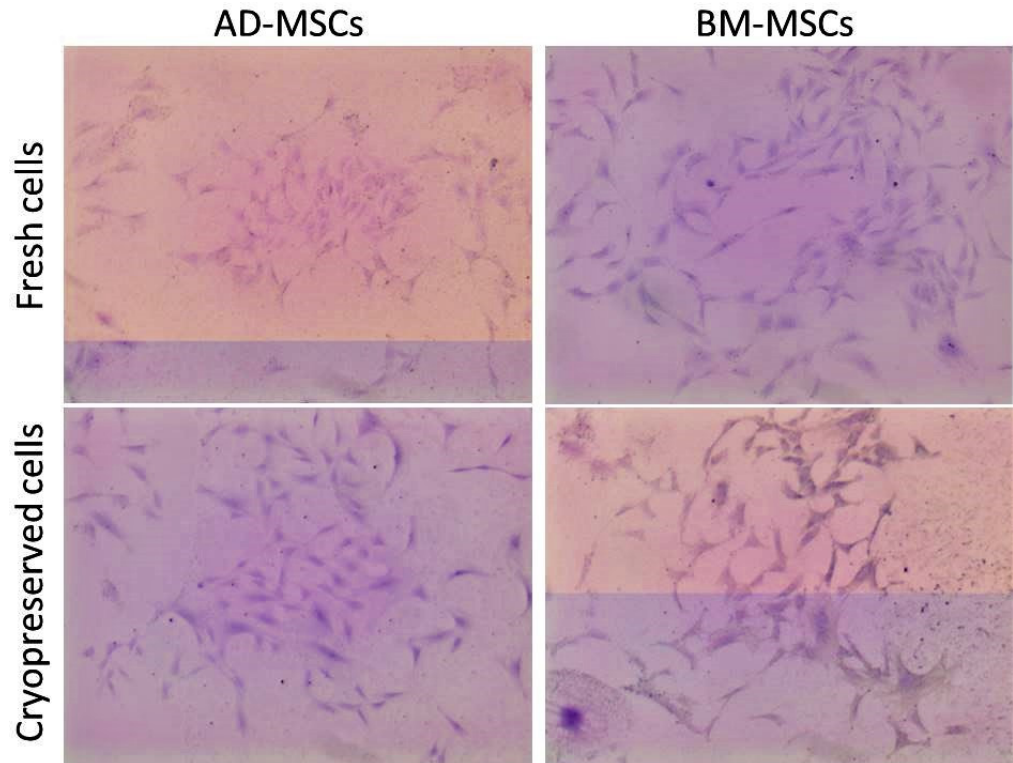
Figure 3. Colony forming unit (fibroblast) formation of MSCs from adipose tissue (AD-MSCs) and bone marrow (BM-MSCs). The passage 3 cells seeded at a low density were counted for aggregates of more than 50 cells stained with crystal violet (0.5%) (Magnification: 4×).